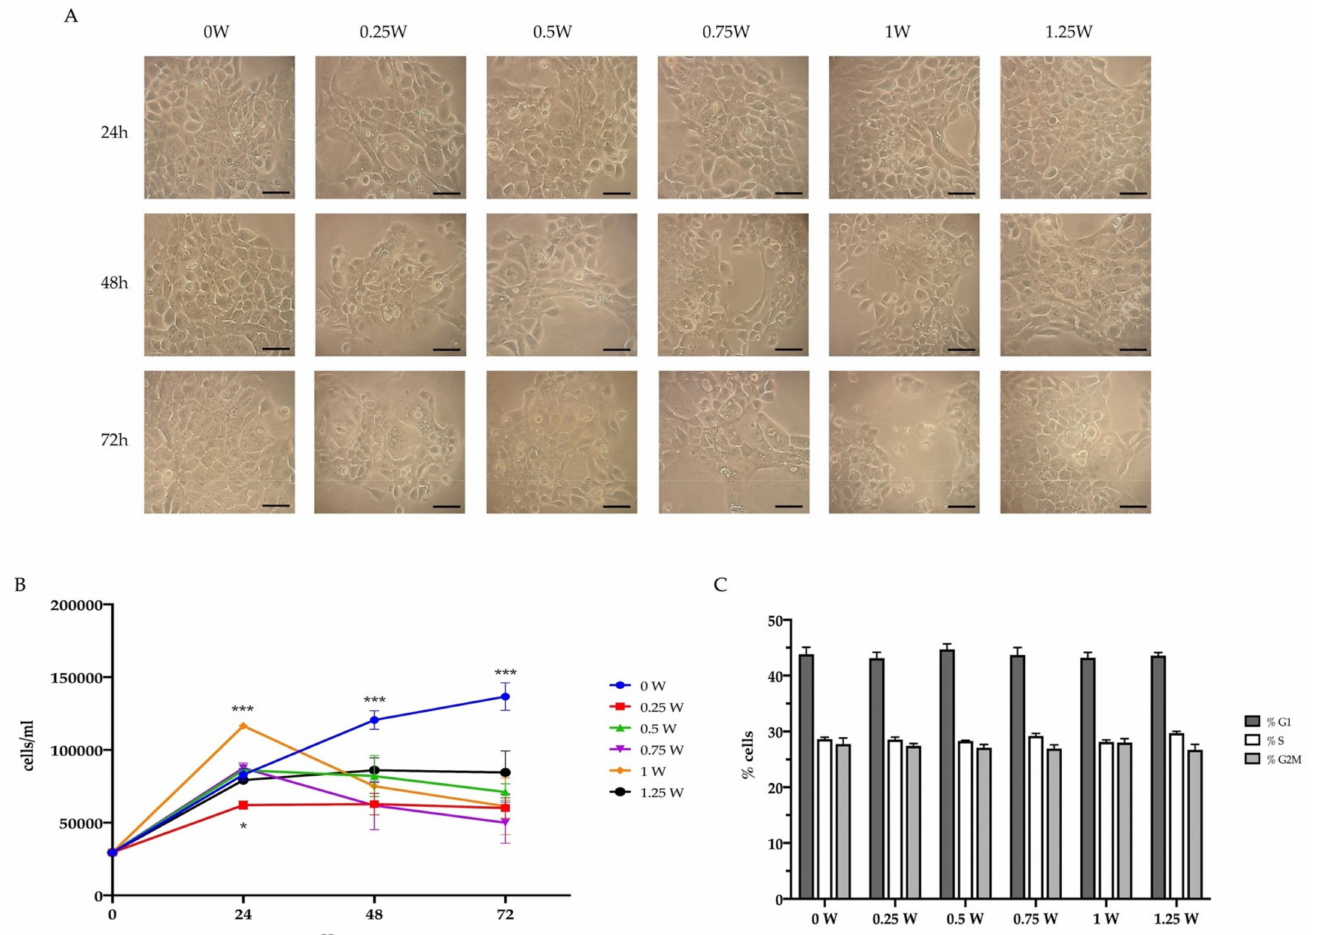
Figure 5. Effect of 808-nm laser irradiation on OHSU-974 FAcorr vitality and proliferation. ( A ) Example of OHSU-974 FAcorr morphology observed at the transmitted-light microscope. Scale bar corresponds to 100 µ m. Each panel is representative of at least five fields of three independent experiments. ( B ) Growth curve of OHSU-974 FAcorr treated or not with an 808-nm laser. ( C ) Proliferative response of OHSU-974 FAcorr cells treated or not with an 808-nm laser 48 h after the irradiation. For panels B and C, data are reported as mean ± SD, and each graph is representative of at least three independent experiments. Statistical significance was tested by two-way ANOVA. * and *** represent p < 0.05 and 0.001, respectively, between the treated sample and the untreated sample (0 W) used as control, at the same time after irradiation. No significant differences were observed in Panel